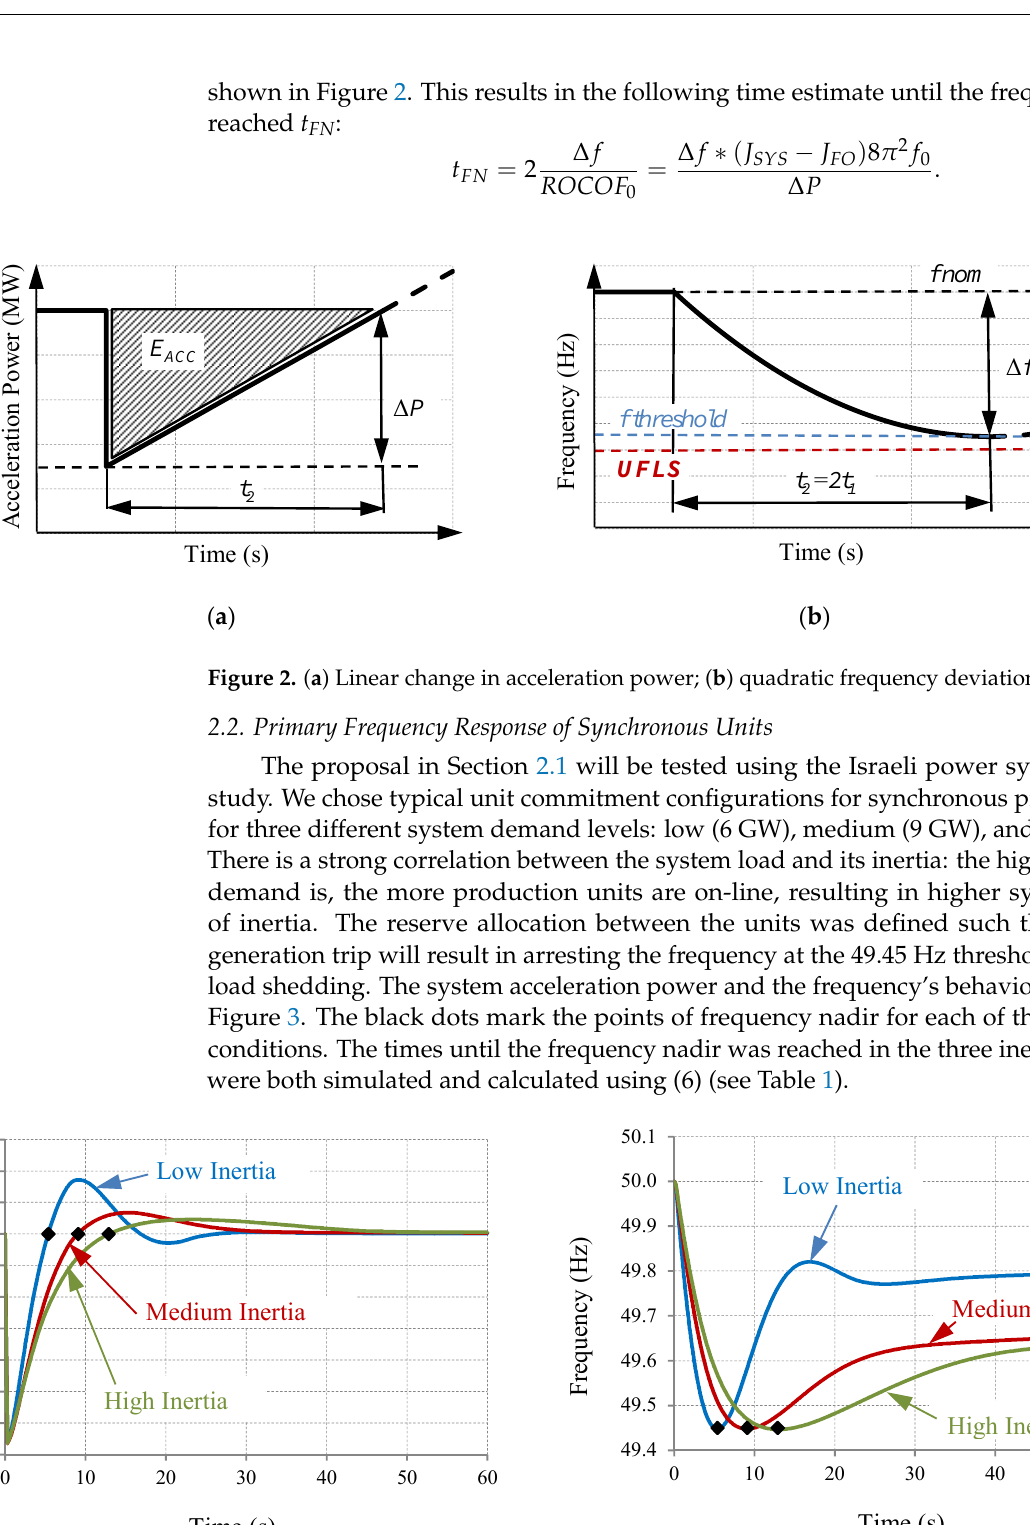
Figure 1. ( a ) Fixed acceleration power; ( b ) linear frequency deviation.